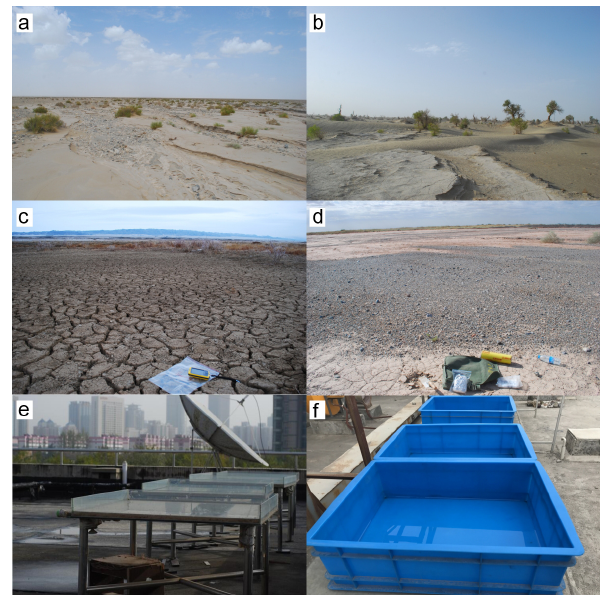
Figure 2. Sampling sites of natural surface sediments in a dry riverbed (a) , desert margin (b) , drainage depressions within sandy desert (c) and Gobi desert (d) , and atmospheric dustfall at XA1 (e) and XA2 (f)